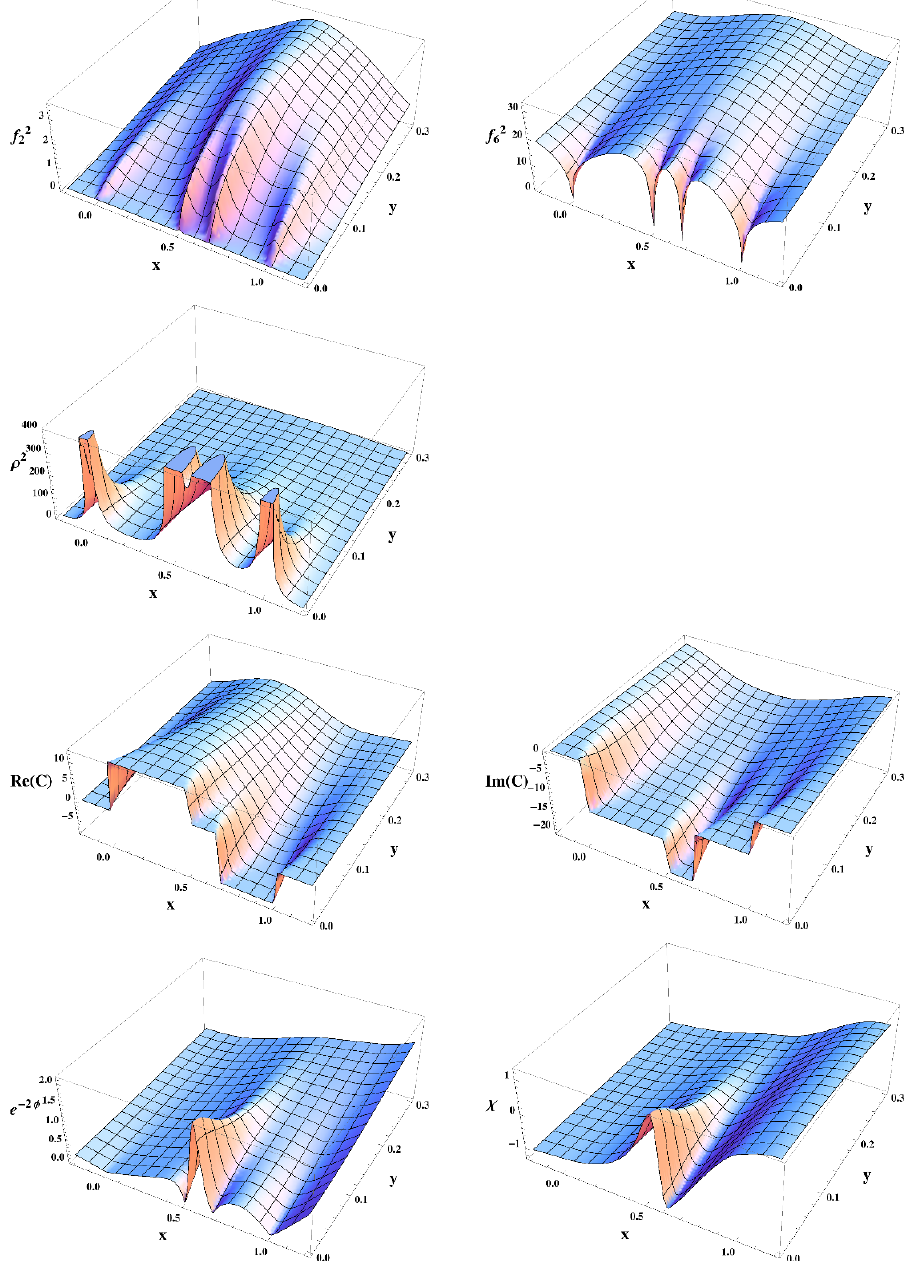
Figure 4 . The four-pole solution: the metric factors f 2 of the two-form potential C and of the axion and dilaton corresponding to the parameters given in (4.10), with N = 2, M = 3. All supergravity functions are regular throughout (cid:6) except for the poles, where their behavior is precisely as discussed in section 3.9.